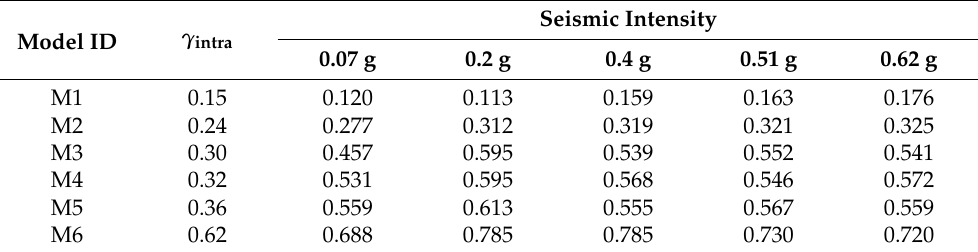
Table 6. The average proportion of base shear across the slope direction is borne by lower- embedding